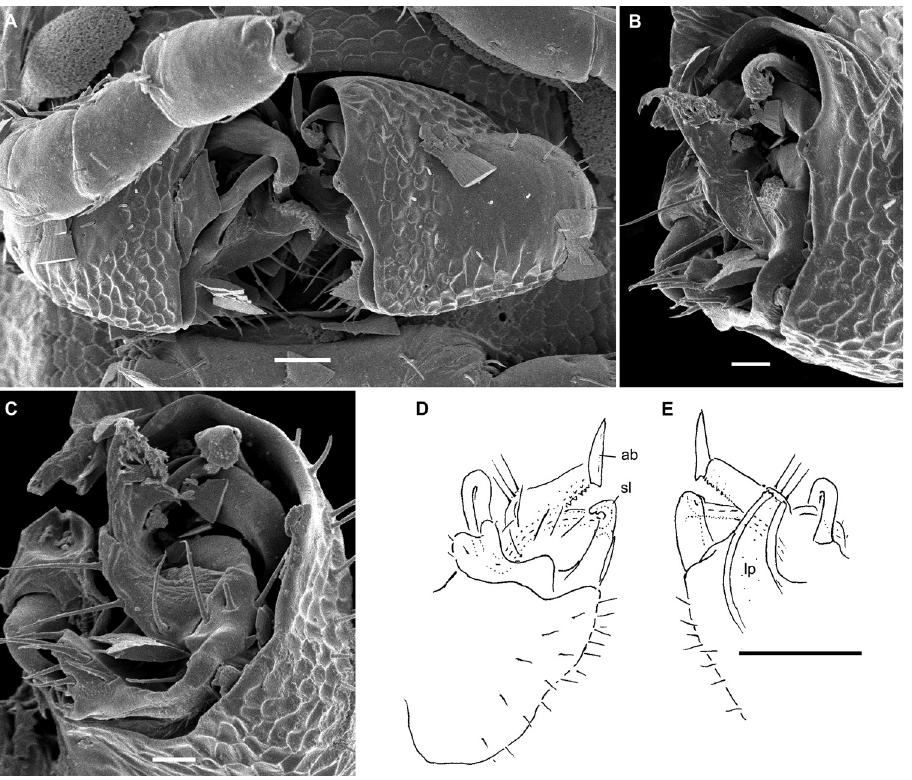
Figure 14. Hemisphaeroparia parva sp. n., ♂ paratypes A SEM micrographs of both gonopods in situ, ventral view B, C SEM micrographs of right gonopod, subcaudal and submesal views, respectively D, E right gonopod, mesal and lateral views, respectively. Scale bars: 0.1 mm ( D, E ), 0.02 mm ( A ), 0.01 mm ( B–C ). Abbreviations: ab apical branch of telopodite, lp lateral process, sl